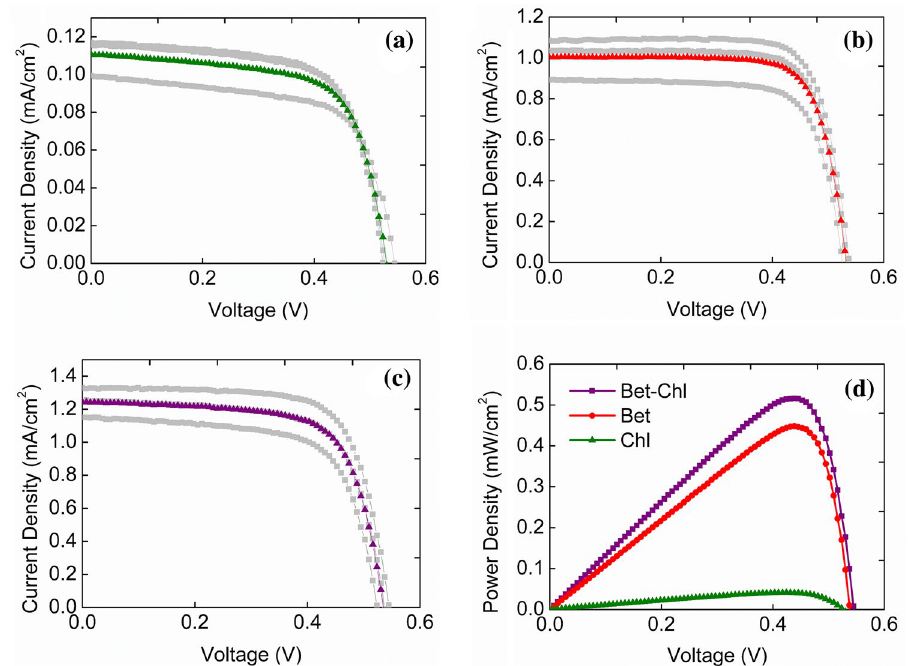
Fig. 5 J – V characteristics of a chlorophyll solar cell, b betanin solar cell, c betanin–chlorophyll solar cell and the d P – V charac- teristics of the three configura-